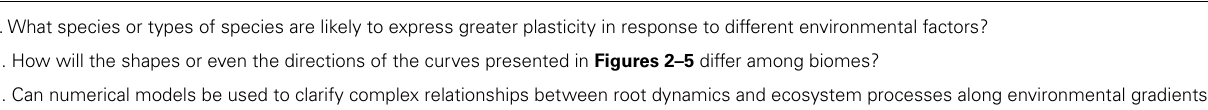
Table 2 | Key questions for future